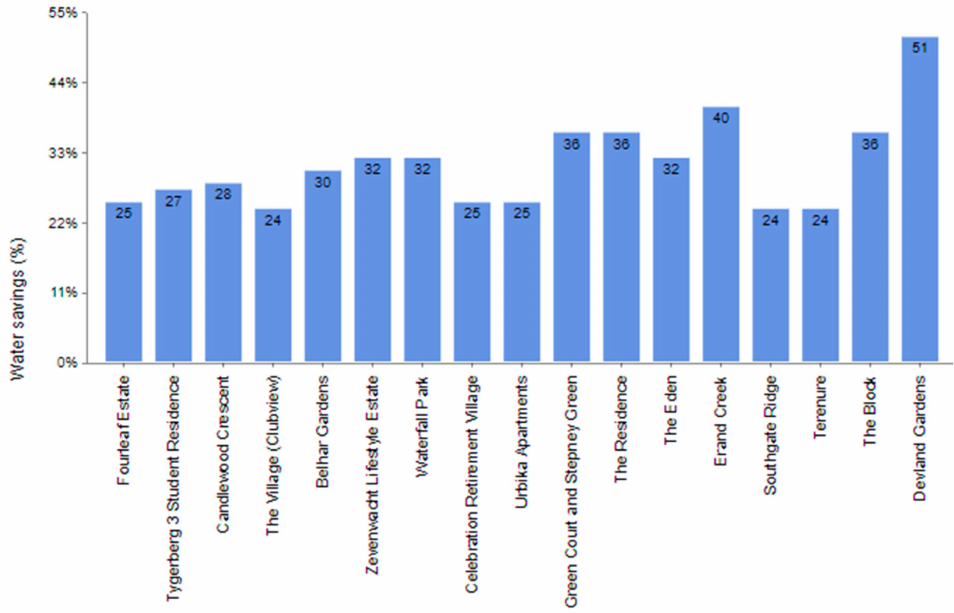
Figure 2. Water savings (%) of the 17 South African Residential complexes with EDGE